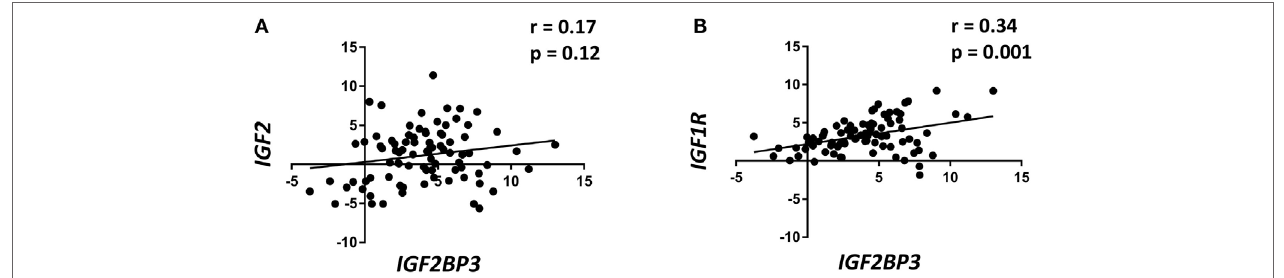
FigUre 1 | Insulin-like growth factor 2 (IGF2) mRNA-binding protein 3 (IGF2BP3) expression is directly correlated with IGF1R expression in Ewing sarcoma (ES) cases. Scatter plot displaying the correlation between IGF2BP3 and IGF2 (a) or IGF1R (B) mRNA levels in 89 ES cases. Correlation coefficient ( r ) and p -value were calculated using Spearman’s correlation test. Human mesenchymal stem cells were used as calibrators (2 −ΔΔ Ct =